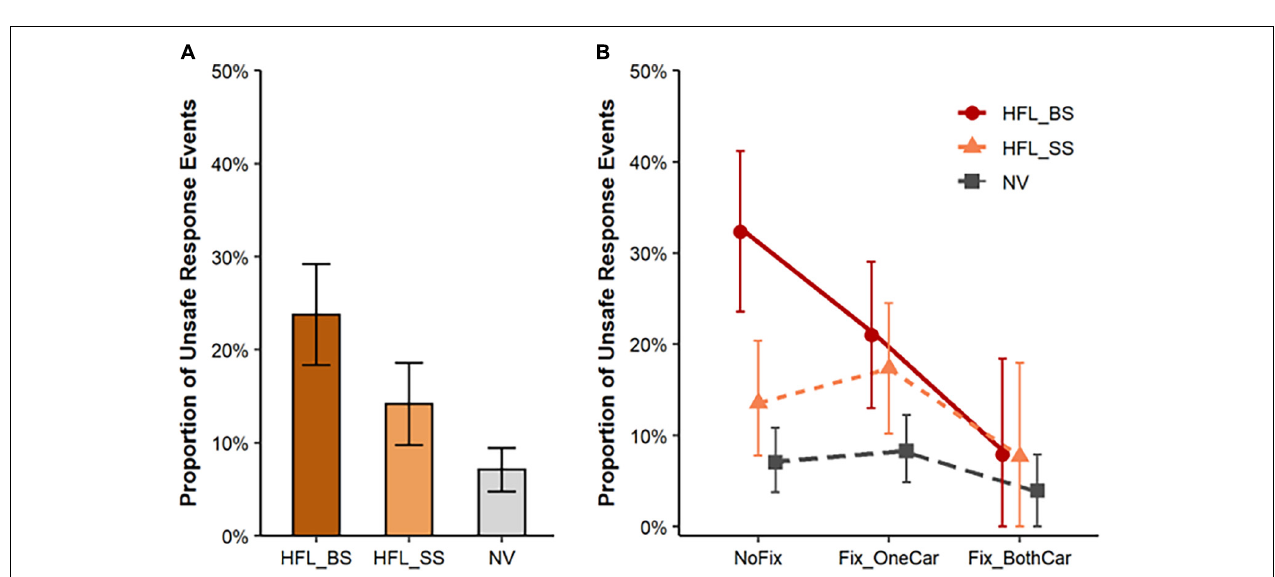
FIGURE 5 | Mean time to first fixation on pedestrians (A) and mean fixation durations on pedestrians (B) . (a) comparison between pedestrian approaching side for HFL (blind and seeing side) and NV groups. (b) comparison among the three cross traffic fixation situations [no fixations on cross traffic (NoFix), fixate on one side of cross-traffic (Fix_OneCar), fixate on both sides of cross traffic (Fix_BothCar)]. Error bars represent SEM.